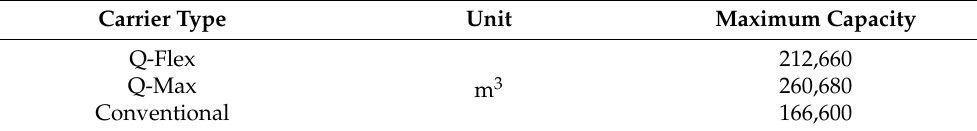
Table 1. Q-Flex, Q-Max, and Conventional carriers’ loading capacity.